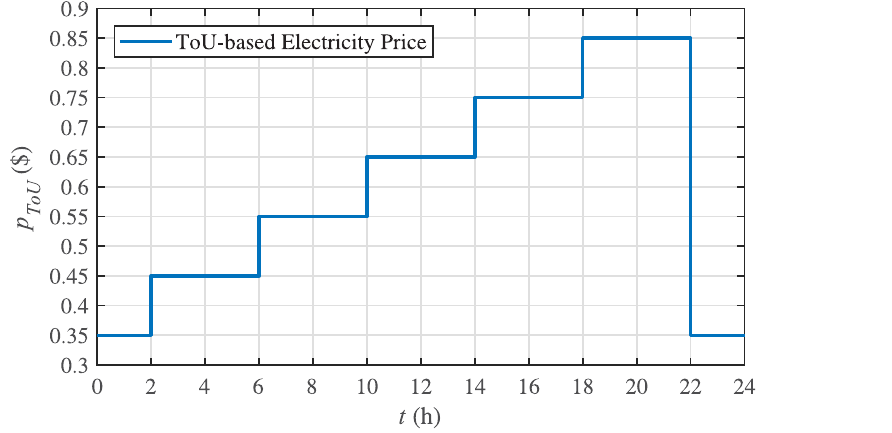
Fig 4. ToU-based electricity price during 24 hours.